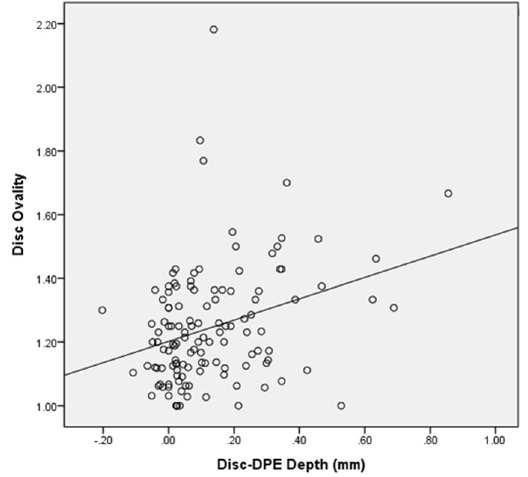
Figure 6. Correlation between the Disc-DPE depth and the disc